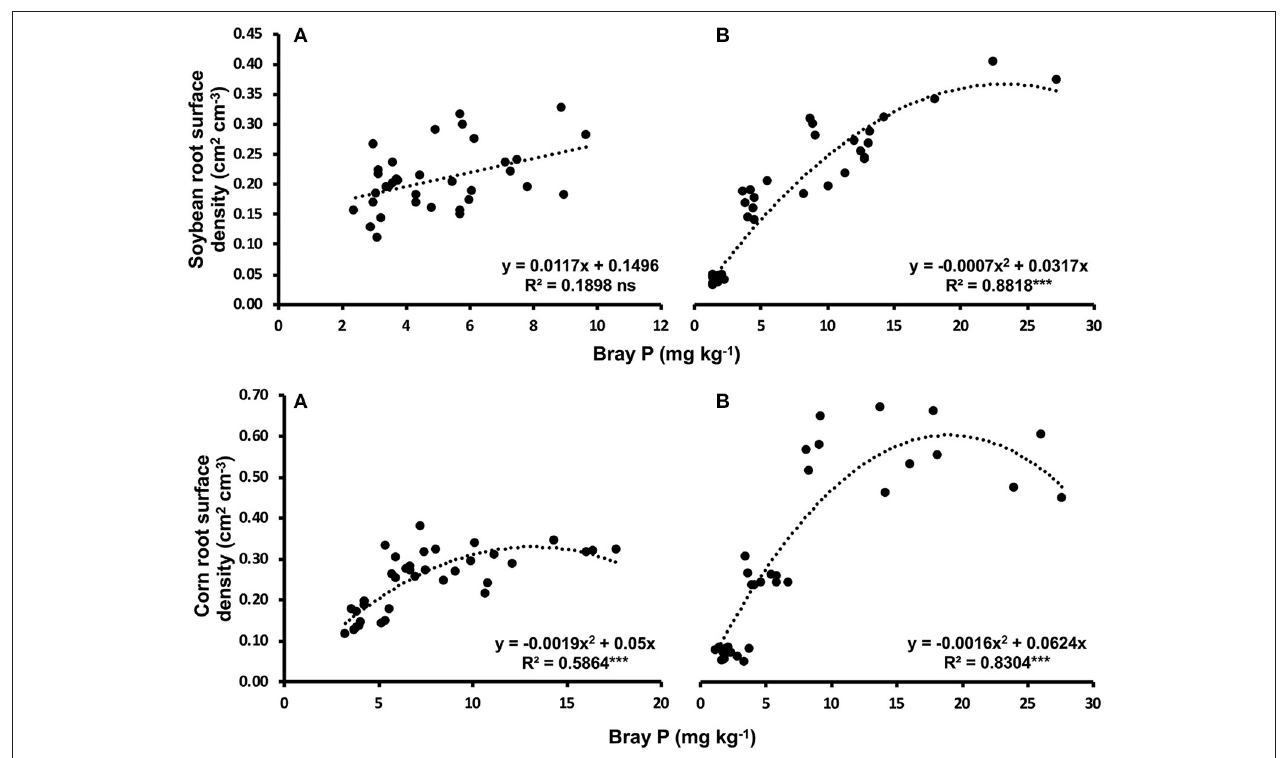
FIGURE 5 | Relationship between soil P availability (Bray-1) and soybean and corn roots surface density in a very clayey Oxisol under conventional tillage (A) and no-tillage (B) . Points represents different combinations between fertilizer sources (TSP or RPR), application modes (row or broadcast) and soil layers (0–5, 5–10, and 10–20cm), with three replicates ( n = 36). ***Significant at 0.1% according to the F